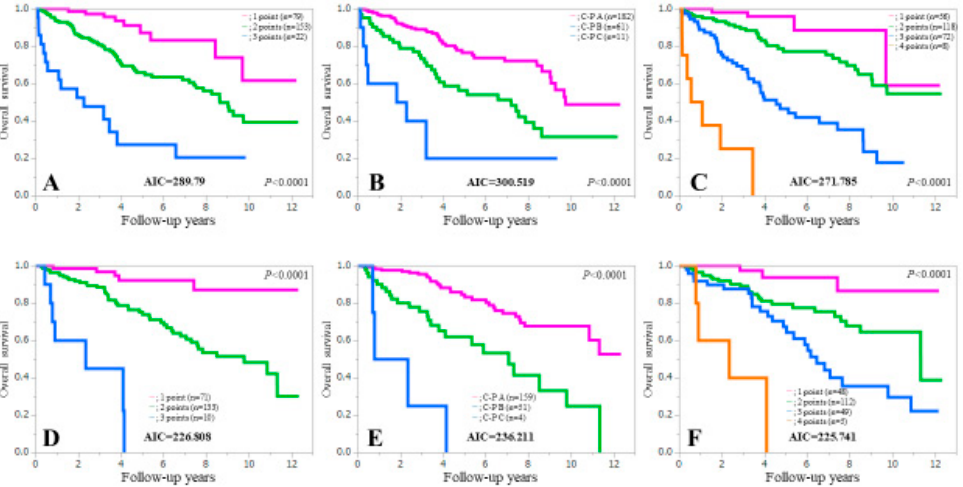
Figure 4. Kaplan-Meier curves in male patients ( n = 254) according to the ALBI grade ( A ), the Child-Pugh classification ( B ) and the ALBI-SMM grade ( C ), and Kaplan-Meier curves in female patients ( n = 214) according to ALBI grade ( D ), the Child-Pugh classification ( E ) and ALBI-SMM grade ( F ).